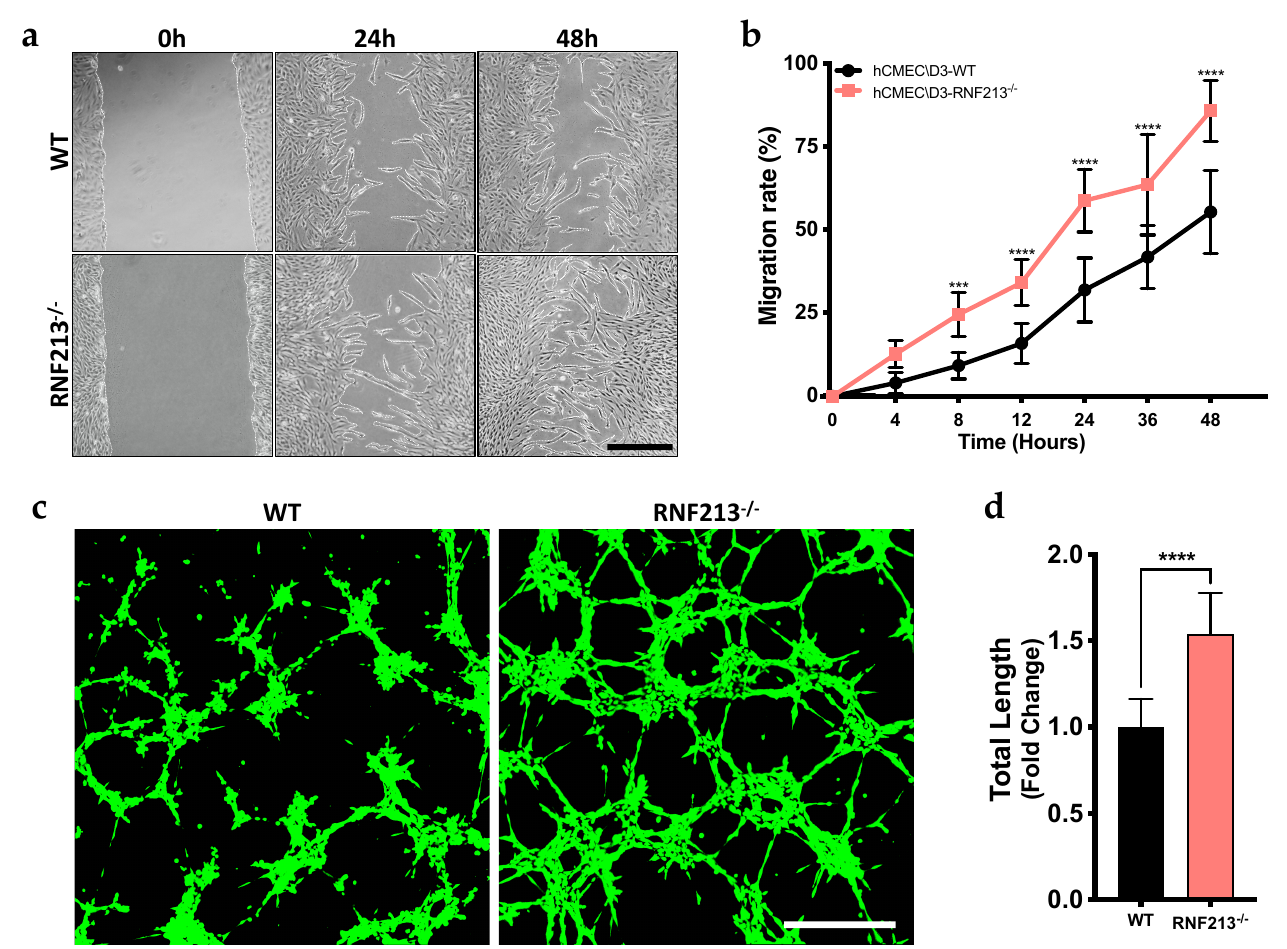
Figure 2. RNF213 deficiency promotes cell migration and tube-like formation. ( a , b ) In vitro scratch assay to evaluate hCMEC/D3 migration rate. Images were captured at different time points using phase-contrast microscope and the rate of migration was measured by reporting the total scratch area at each point to the area at time 0 h. n = 6–7; ( c ) Tube formation assay on Matrigel ® with hCMEC/D3; ( d ) Quantification of the capillary-like networks total length measured using angiogenesis analyser on ImageJ software and reported in fold change relative to WT control. n = 10. Scale bar = 500 µ m. *** p < 0.001 and **** p <